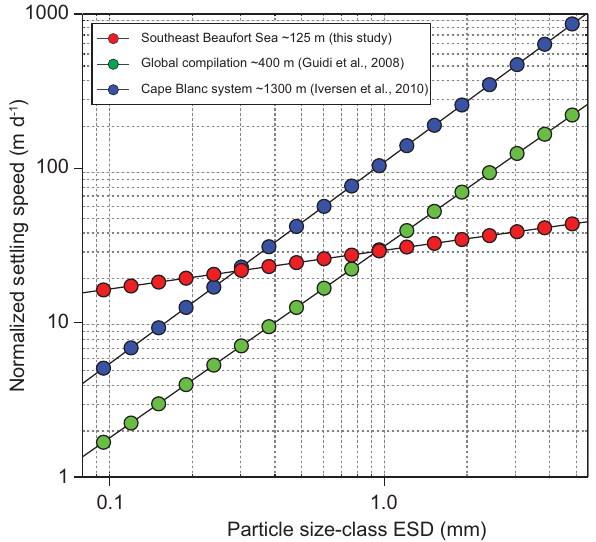
Fig. 11. Modeled settling speeds obtained from coefficient A and scaling exponent b of the empirical power-law relationships com- puted by the minimization procedure between particle size estima- tions by underwater cameras and corresponding mass fluxes (see Table 2). The settling speeds were computed using Stokes’ law and normalized using a water density of 1027kgm − 3 and a kinematic viscosity of 0.894×10 − 6 m 2 s − 1